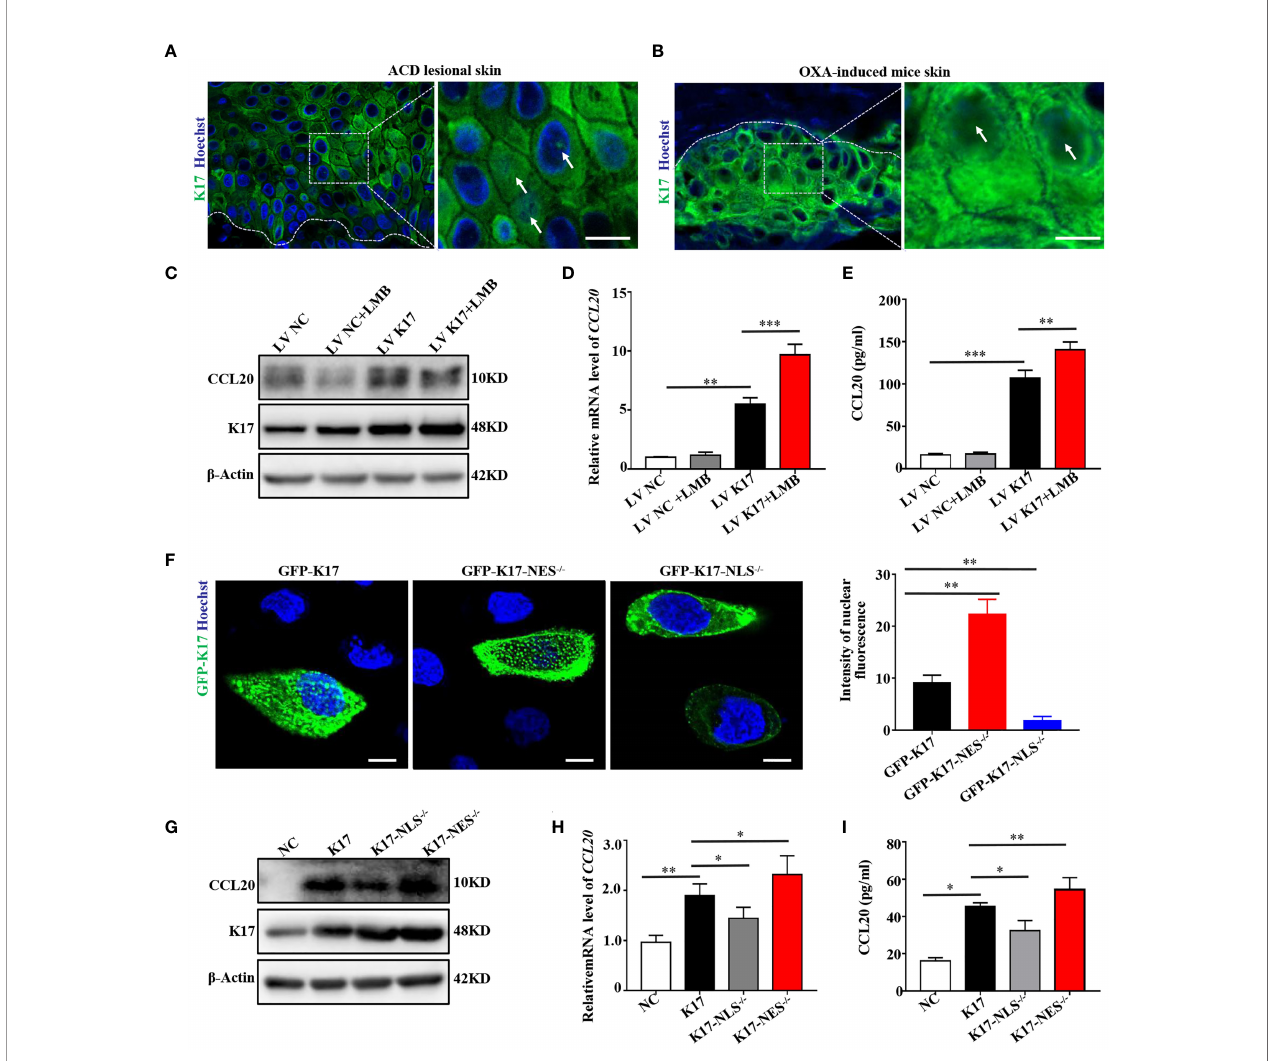
FIGURE 5 | K17 upregulates CCL20 expression dependent on its nuclear translocation. Immuno fl uorescence staining for K17 located in the nucleus of keratinocytes in lesional skin from (A) ACD patients ( n = 3) and (B) OXA-induced mice ( n = 3). K17 (green) and Hoechst (blue). Scale bar, 10 m m. (C) K17 and CCL20 protein levels were determined using western blot. (D) Relative CCL20 mRNA expression analyzed by qRT-PCR. (E) CCL20 levels secreted into HaCaT cell culture medium were measured by ELISA. (F) Immuno fl uorescence staining of K17 distributed in the nuclei of HaCaT cells transfected with WT GFP-K17 and mutant GFP-K17 and the intensity of nuclear fl uorescence per unit area. Scale bar, 10 m m. (G) K17 and CCL20 levels were analyzed by western blot. (H) Relative CCL20 mRNA expression was analyzed by qRT-PCR. (I) CCL20 levels secreted into HaCaT cell culture medium were measured by ELISA. Data represent the mean ± SD ( n = 3). * p < 0.05, ** p < 0.01, *** p < 0.001. All experiments were repeated for at least three